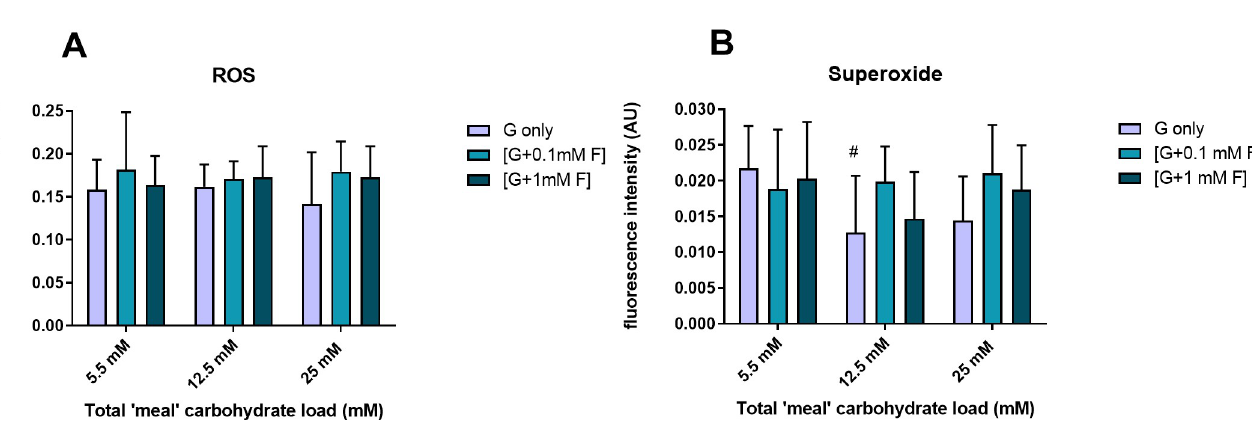
PLOS ONE | https://doi.org/10.1371/journal.pone.0267675 May 13,